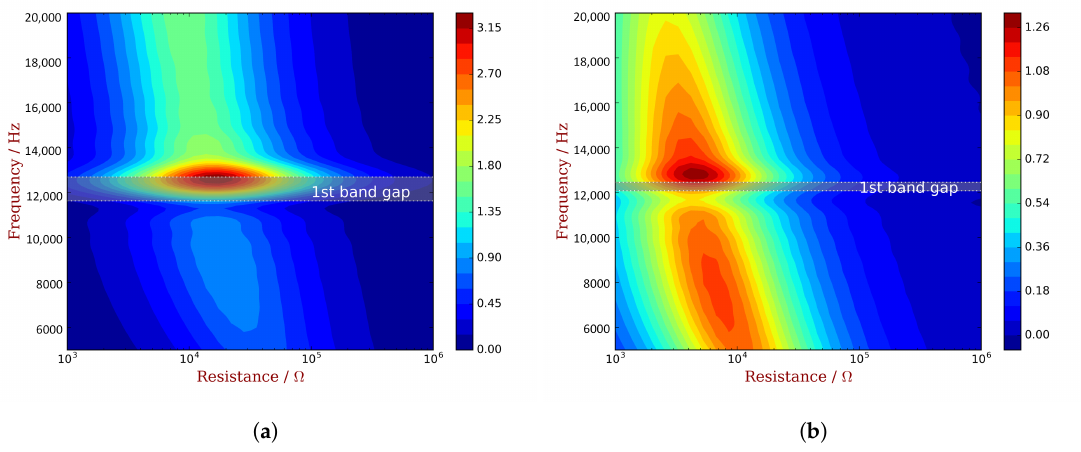
Figure 15. Parametric study of power transmission loss with respect to frequency and resistance, when the piezoelectric waveguides use: ( a ) unit cell A; ( b ) unit cell C.